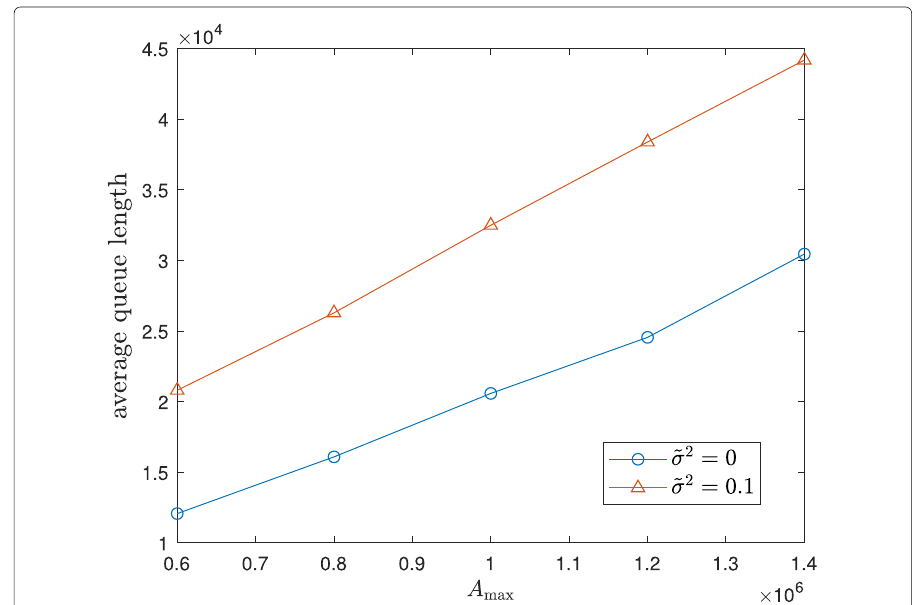
Fig. 6 The time-averaged queue length versus the average data arrival rate A max